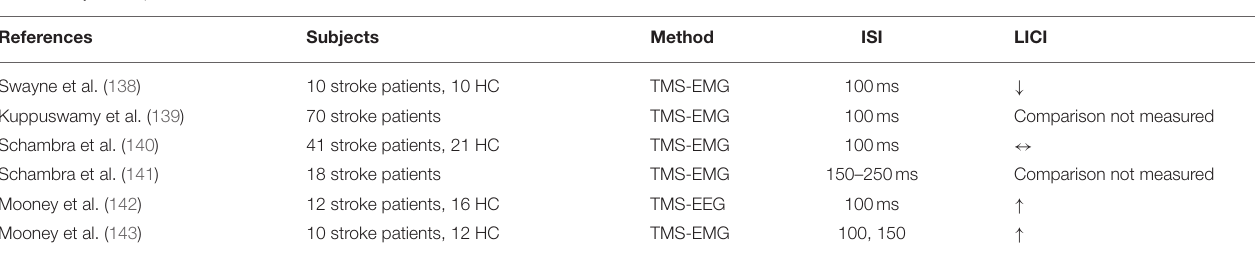
TABLE 12 | LICI in patients with